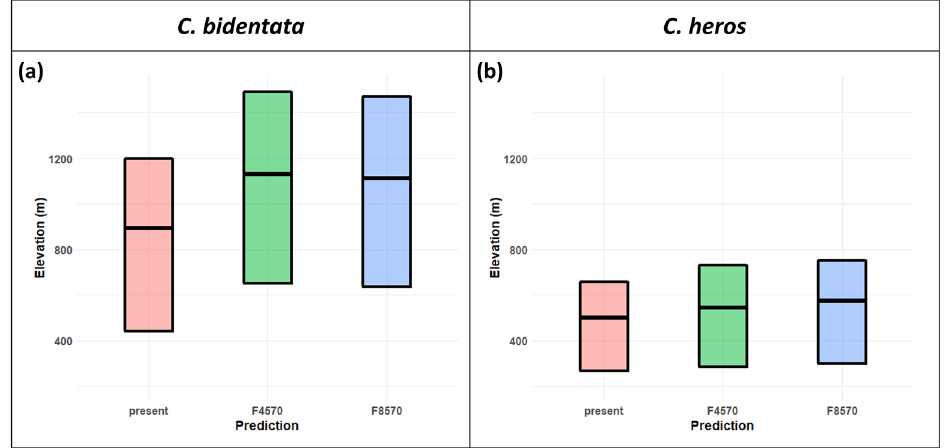
Figure 5. Crossbar visualization of elevation shift for C. bidentata ( a ) C. heros ( b ) in the future SDM models. The bars show the upper and lower quartile and mean of the values or centroid query from the variables where the projections for the future indicate “stable” or “gain” outcome).